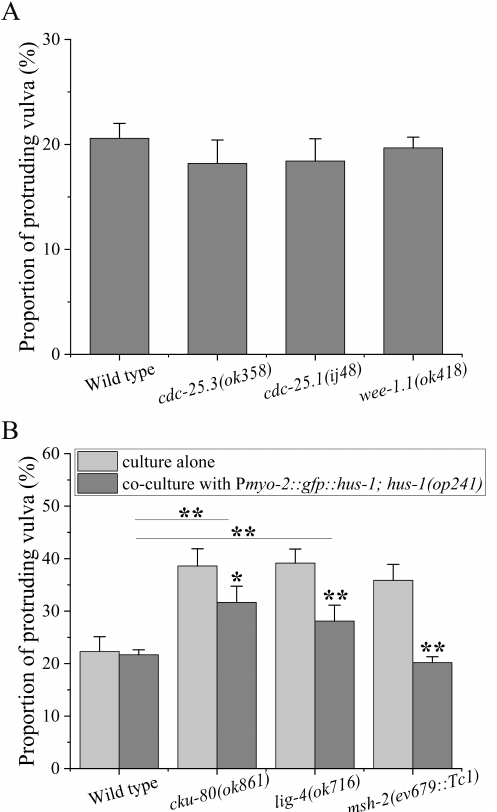
Figure 4. Regulation of pharyngeal ATR cascade on NHEJ repair of the vulva: ( A ) the vulva radiosensitivity of cdc-25.1 , cdc-25.3 , and wee-1.1 worms; ( B ) the vulval radiosensitivity of cku-80 , lig-4 , and msh-2 worms co-cultured with worm line BPL1121: P myo-2::gfp::hus-1; hus-1(op241) . Results are means ± SD ( n ≥ 3, t -test, * p < 0.05 and ** p <